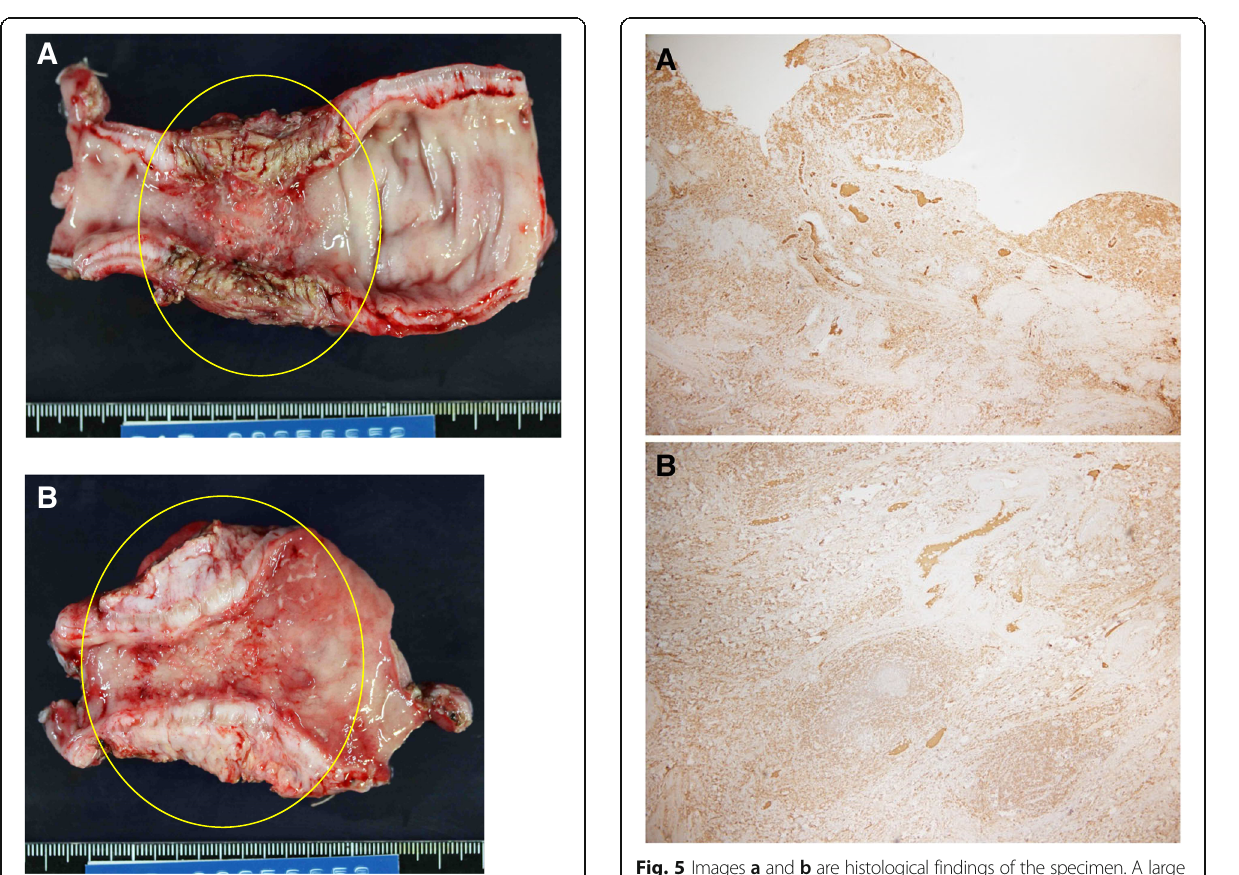
Fig. 4 Images a and b are macroscopic findings of the specimen. Two specimens of the ileum with a rubbery appearance and extraordinarily thick walls (yellow circles in the image a and b